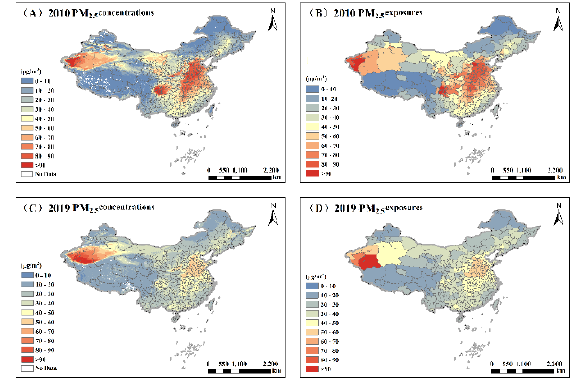
Figure 2. PM 2.5 concentration and population exposure distribution in China in 2010 and